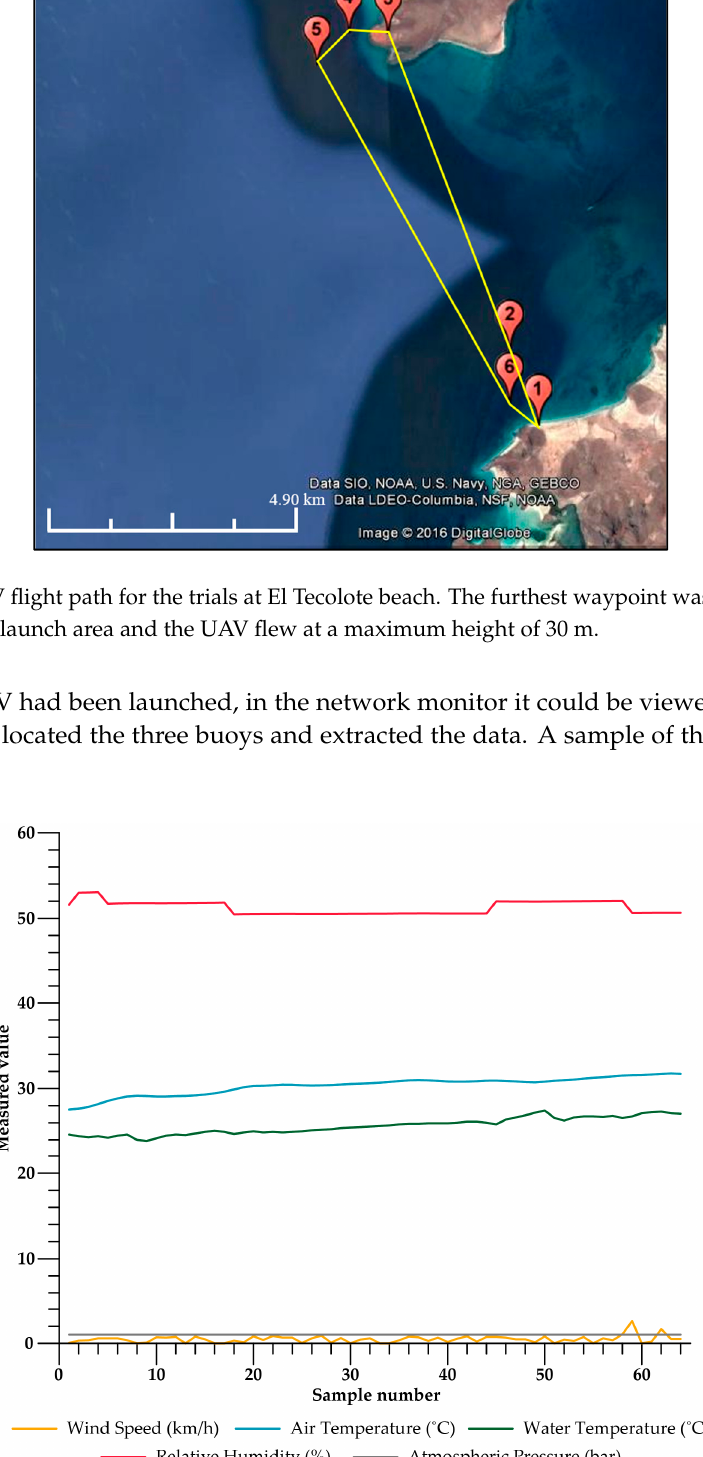
Figure 16. Data extracted by the master node from one of the buoys.